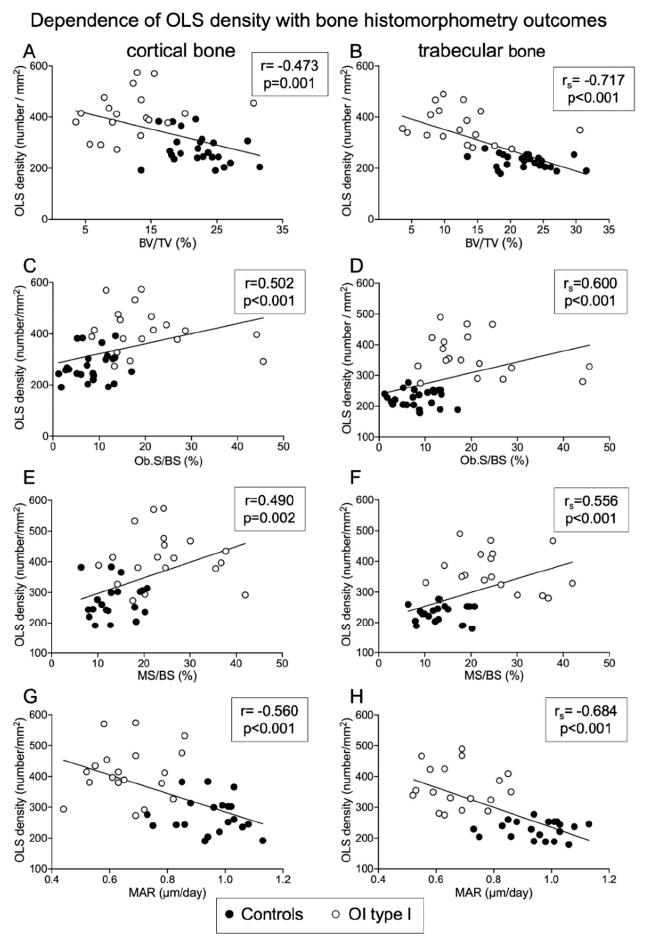
Figure 5. Dependency of OLS density with bone histomorphometric parameters (total sample analysis): OLS density is negatively correlated with structural parameters such as BV/TV ( A , B ), positively correlated with static (Ob.S/BS) and dynamic (MS/BS) surface-based bone formation indices ( C – F ), and negatively correlated with indices of osteoblast function as mentioned above (MAR) ( G , H ).